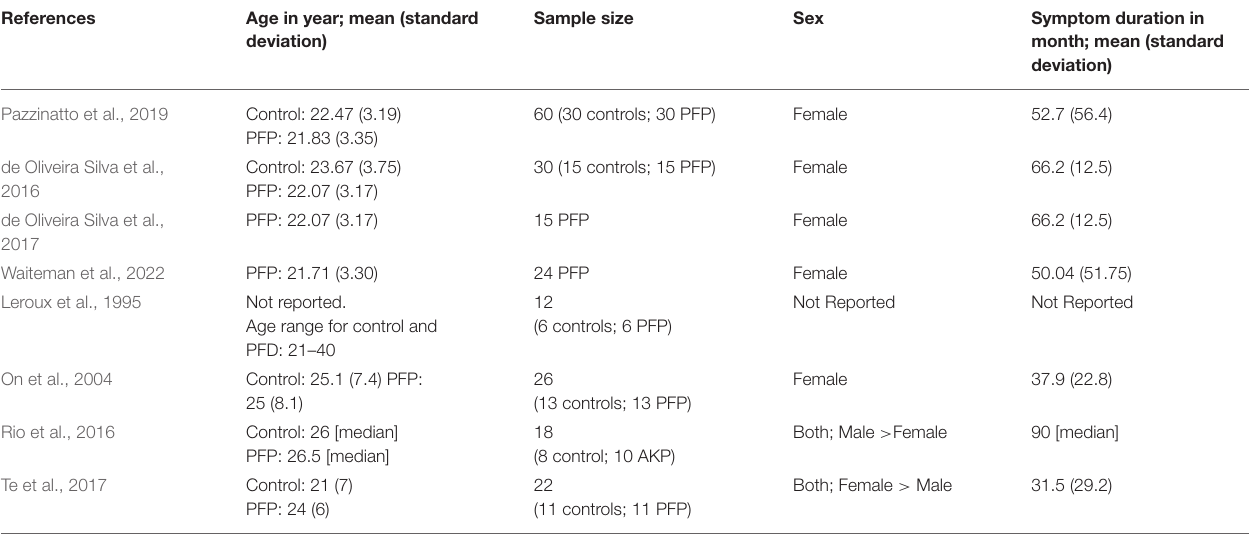
TABLE 1 | Study characteristics and participant demographics for included studies.